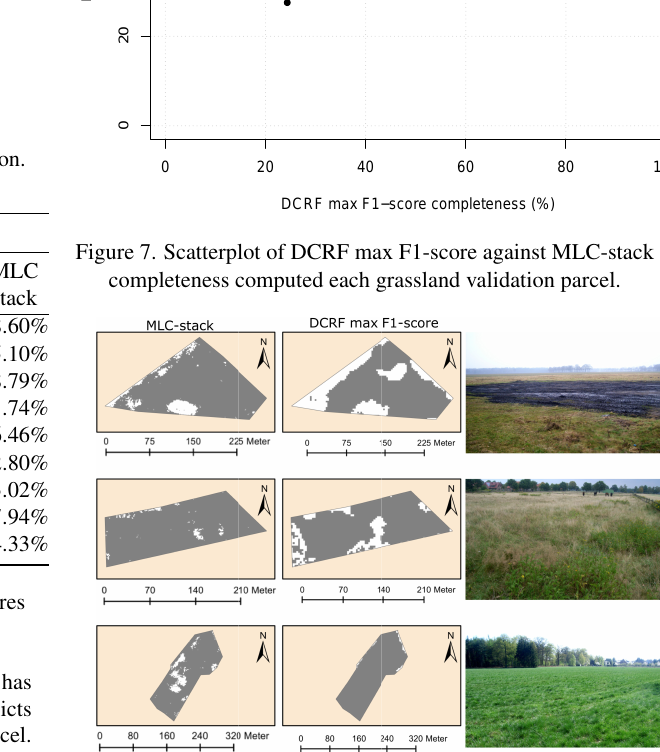
Figure 8. Grassland parcels as classified by MLC-stack and DCRF max F1-score and corresponding ground referencing photos. Top to bottom row corresponds to parcel numbers 49, 8, and 11 respectively as shown in Fig. 7. Grey and white areas correspond to grasslands and misclassifications